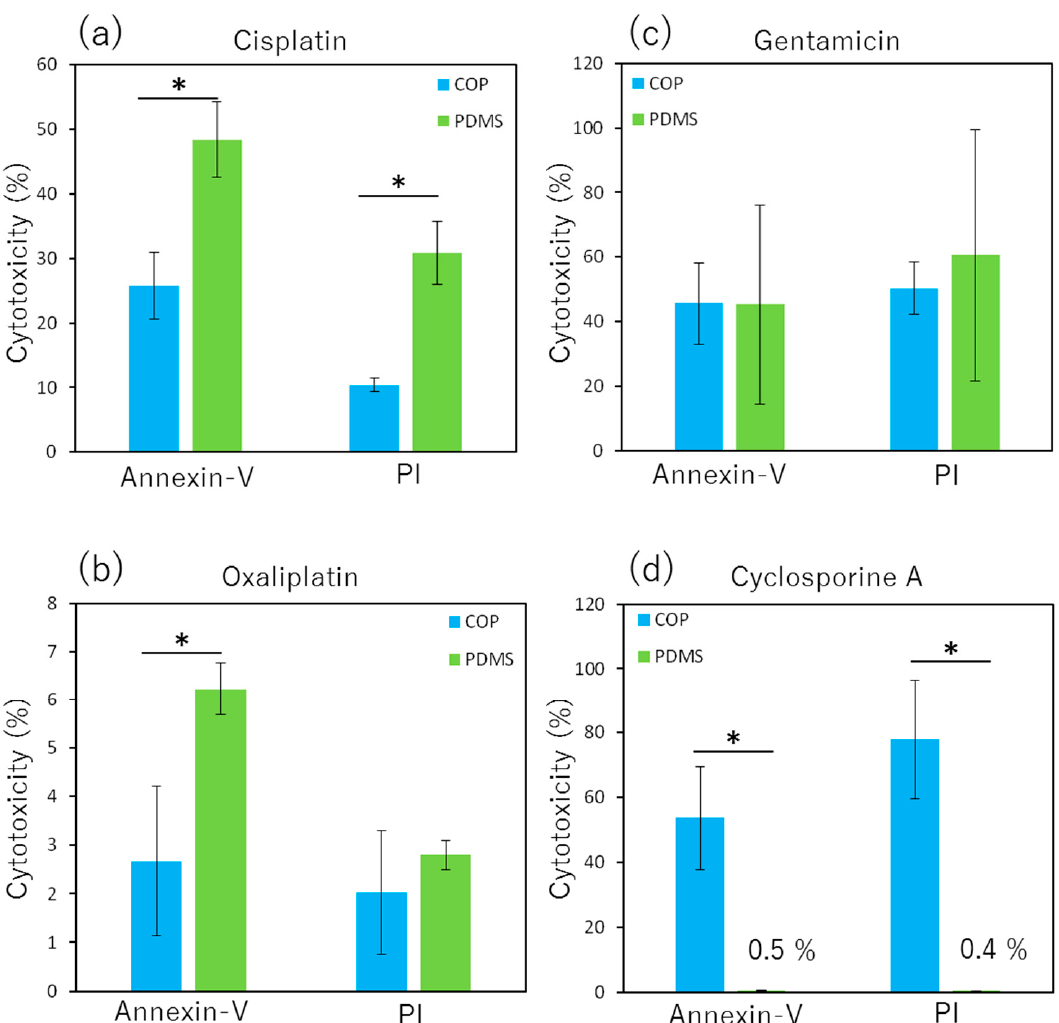
Figure 6. Cytotoxicity of each nephrotoxic drug on RPTEC cultured in COP-MPS and PDMS-MPS. ( a ) Cisplatin; ( b ) Oxaliplatin; ( c ) Gentamicin; ( d ) Cyclosporine A. Data are presented as mean ± SD (technical replicates, n = 3). * p < 0.05.